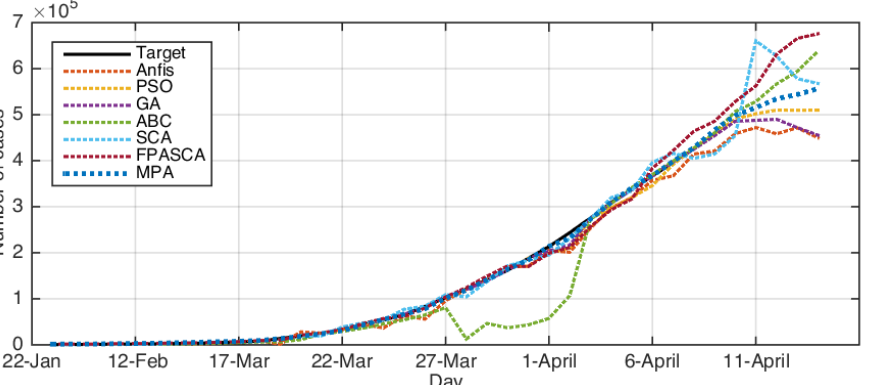
Figure 3. The results for the USA using ABC, ANFIS, FPASSA, GA, MPA, SCA, and PSO against real data (target).